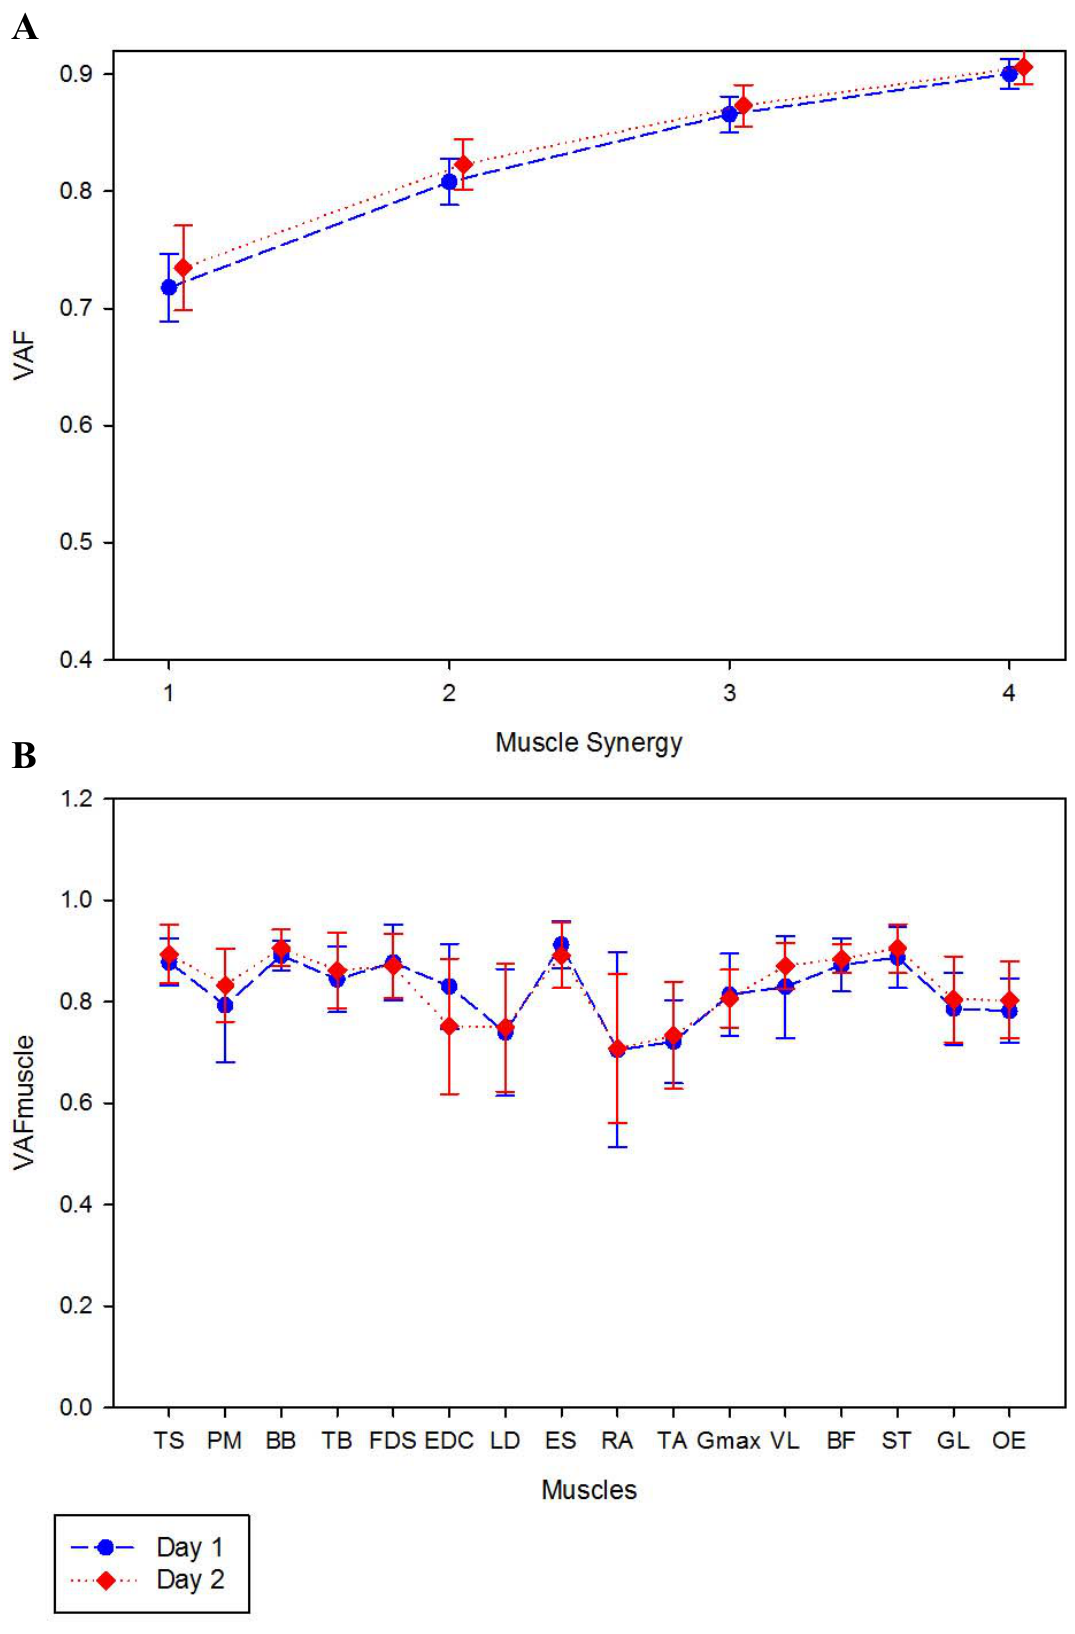
Figure 1. Mean values of global ( A ) and local ( B ) variance accounted for, VAF and VAFmuscle, for day 1 and 2.